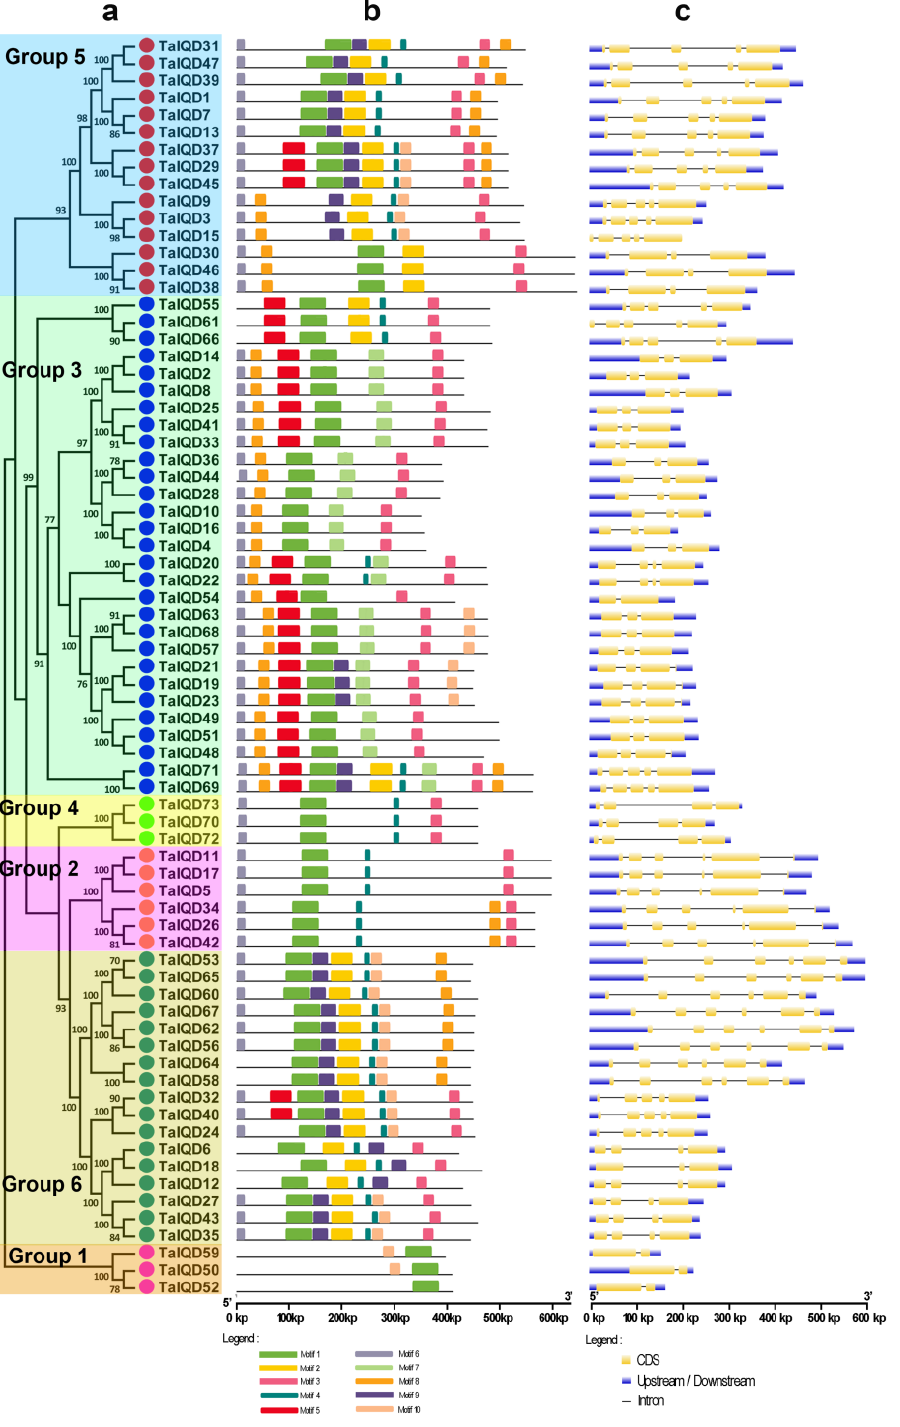
Figure 2. Phylogenetic relationships, gene structures, and conserved motifs among the 73 TaIQDs . ( a ) The phylogenetic tree was constructed with the full-length sequences of TaIQD proteins using MEGA6.0 software. ( b ) The motif compositions of the TaIQD proteins. Schematic representations of the 10 conserved motifs in the TaIQD proteins. The motifs, numbered 1–10, are indicated by different colored boxes. ( c ) Exon–intron structures of the TaIQD genes. Yellow boxes represent exons, grey lines indicate introns, and blue boxes represent untranslated 5 (cid:48) and 3 (cid:48)